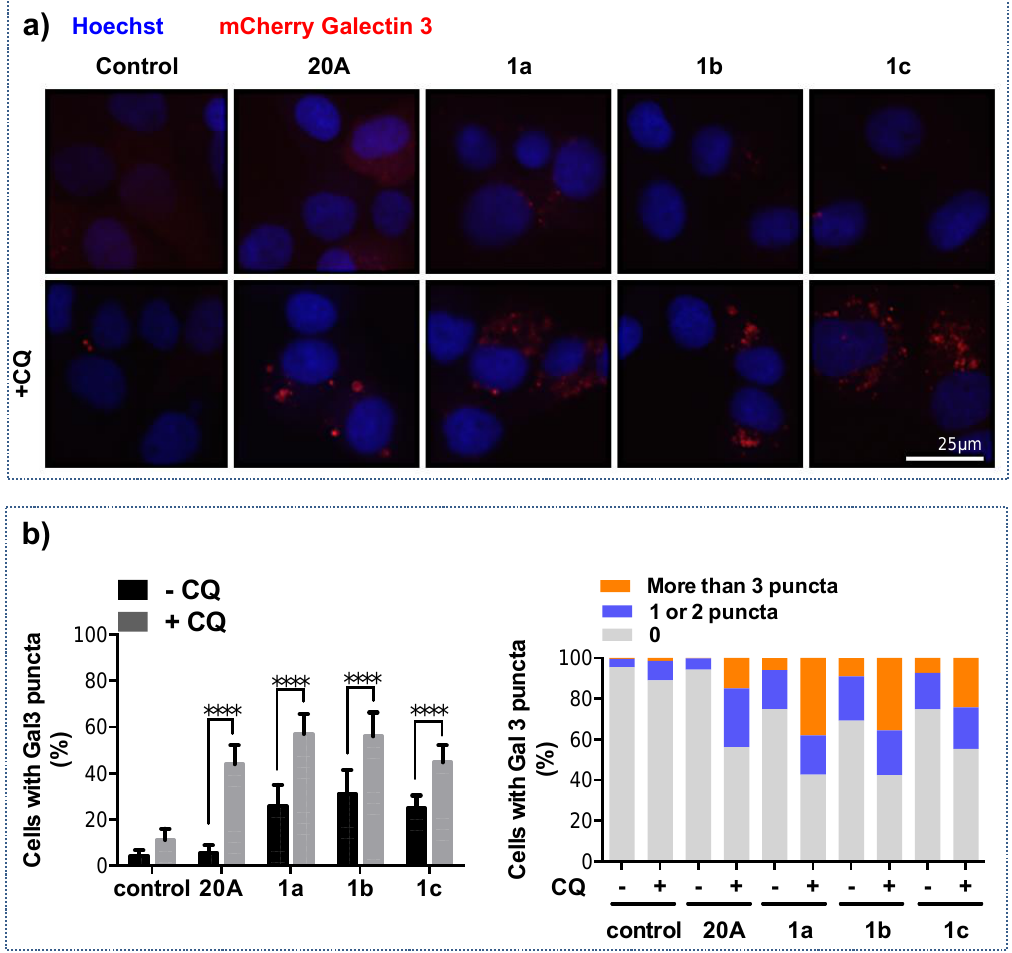
Figure 6. Chloroquine enhances LMP triggered by 20A derivatives. ( a ) mCherry-Galectin3 expressing U2OS cells were treated with or without 3 µM 20A , 2 µM 1a , 1 µM 1b or 1 µM 1c in either the presence